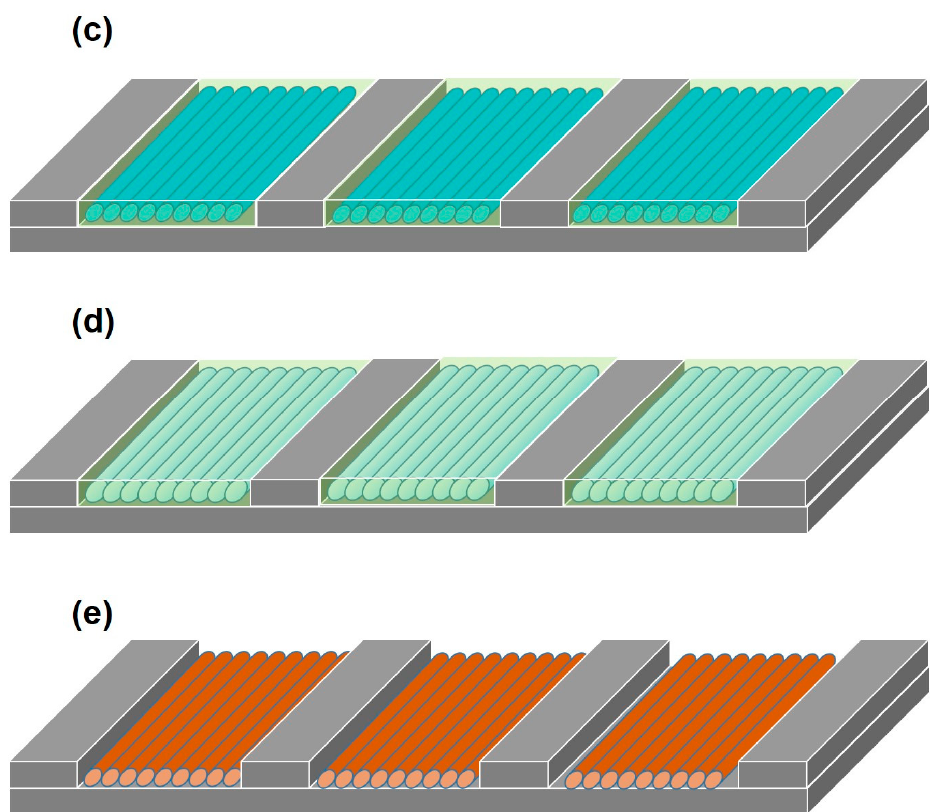
Figure 2. Process flow for developing aligned WO 3 nanowires from PS- b -P4VP BCP. ( a ) Trenched SSQ substrate via nanoimprint lithography. ( b ) Spin-coating of PS- b -P4VP block copolymer. ( c ) Line features after solvent vapor annealing. ( d ) Swollen P4VP features after ethanol “activation”. ( e ) Deposition